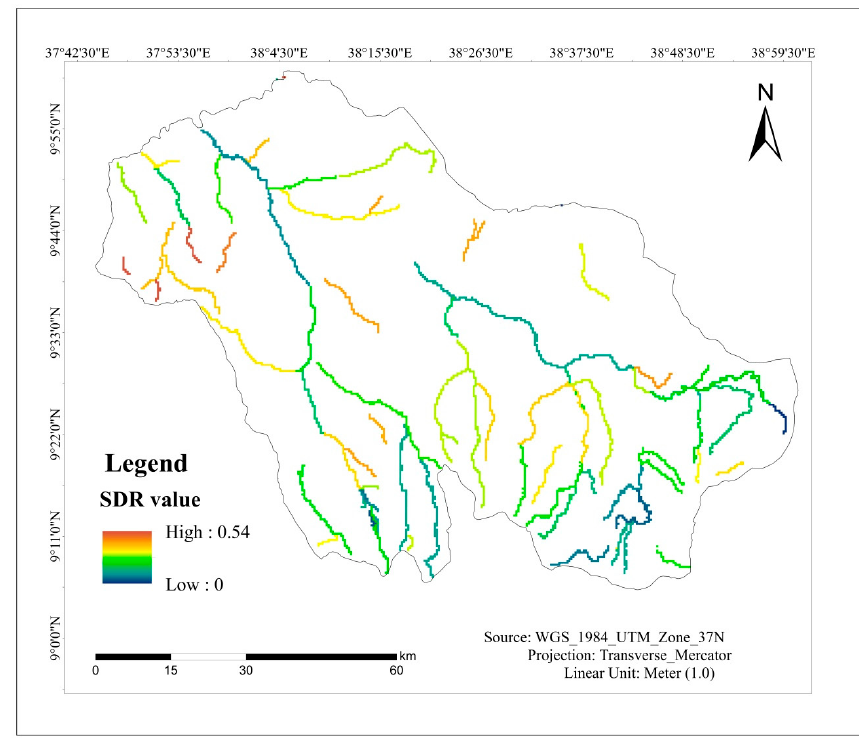
Figure 11. Map of sediment delivery ratio (SDR) the Muger